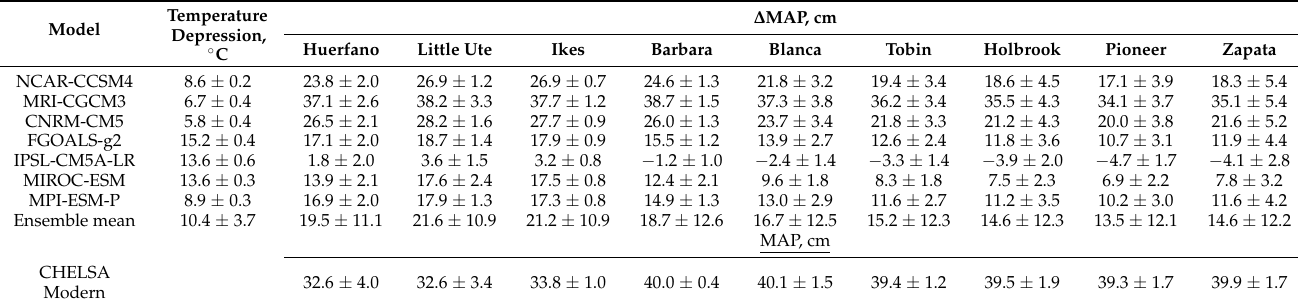
Table 5. Mean LGM temperature depression over the study area and change in MAP ( ∆ MAP) for individual glacier areas based on the CHELSA downscaling of PMIP3 models and modern climate (1979–2013). Note that the standard deviation reported for the ensemble means reflects the spread in the results from individual models, not that for the grid values in the ensemble means.